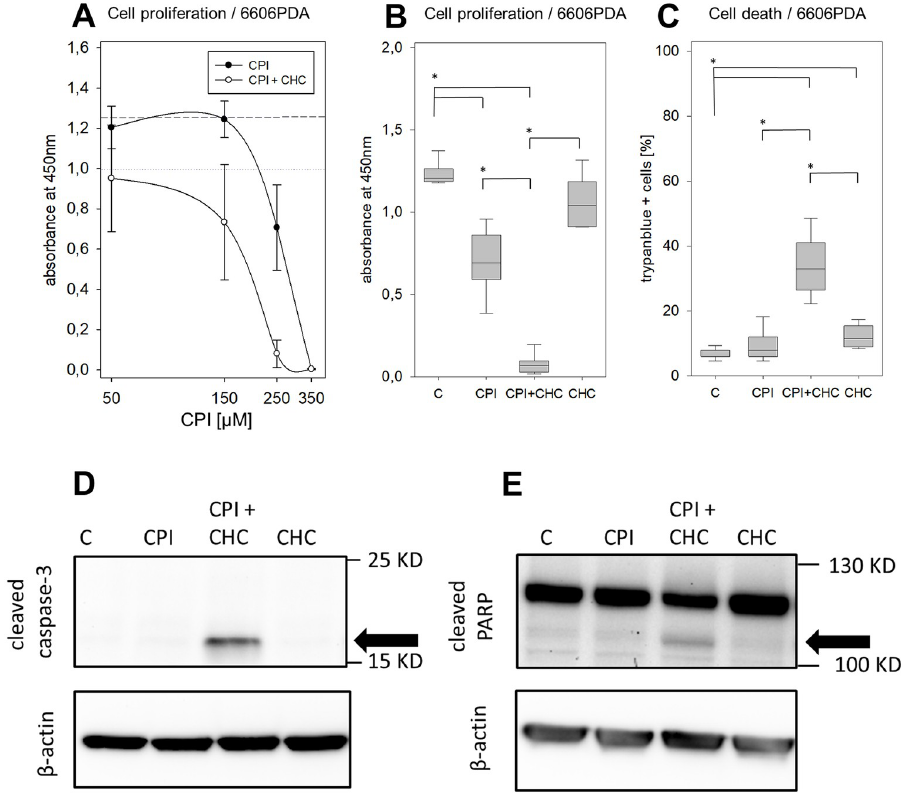
Fig 1. CPI-613 in combination with CHC leads to a reduction in pancreatic cancer cell proliferation and viability. ( A ) Quantification of proliferation by BrdU-ELISA, dose-response curve after 48 h treatment of 6606PDA cells with CPI-613 (50–350 μ M), with and without 5 mM CHC (dotted lines indicate mean value of absorbance for control treated cells, either with high or low DMSO concentrations). ( B ) Evaluation of cell proliferation with vehicle control (medium with the respective amount of vehicle, DMSO) (C), 250 μ M CPI-613 (CPI), 5 mM CHC (CHC) and the combination (CPI + CHC). ( C ) Evaluation of cell death by trypan blue assay after cultivating 6606PDA cells for 48 h with vehicle control with DMSO (C), or medium supplemented with 150 μ M CPI-613 (CPI), 5 mM CHC and CPI-613 plus CHC (CPI + CHC). ( D ) Apoptosis was evaluated by quantifying cleavage of caspase 3 (caspase-3) and PARP ( E ) via western blot, after treating the cells 24 h with DMSO only (C), 150 μ M CPI-613, 5 mM CHC or the combination (the bands of the cleaved proteins are indicated by black arrows). Statistics were performed with ANOVA on Ranks and correction for multi comparison by Holm-Sidak method, significant differences: � p � 0.002; Independent experiments: A-B: n = 5–7, C: n = 7, D-E: n = 3.